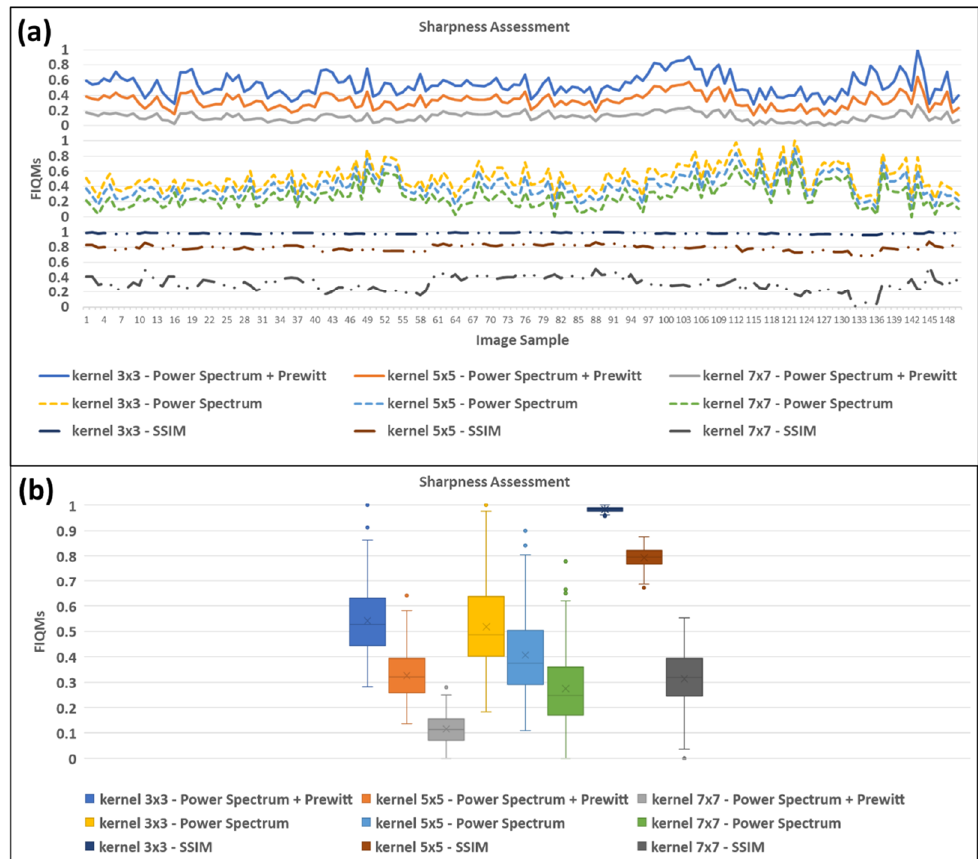
Figure 7. Experimental results of Sharpness Assessment: ( a ) box and whisker plot and ( b ) line chart.